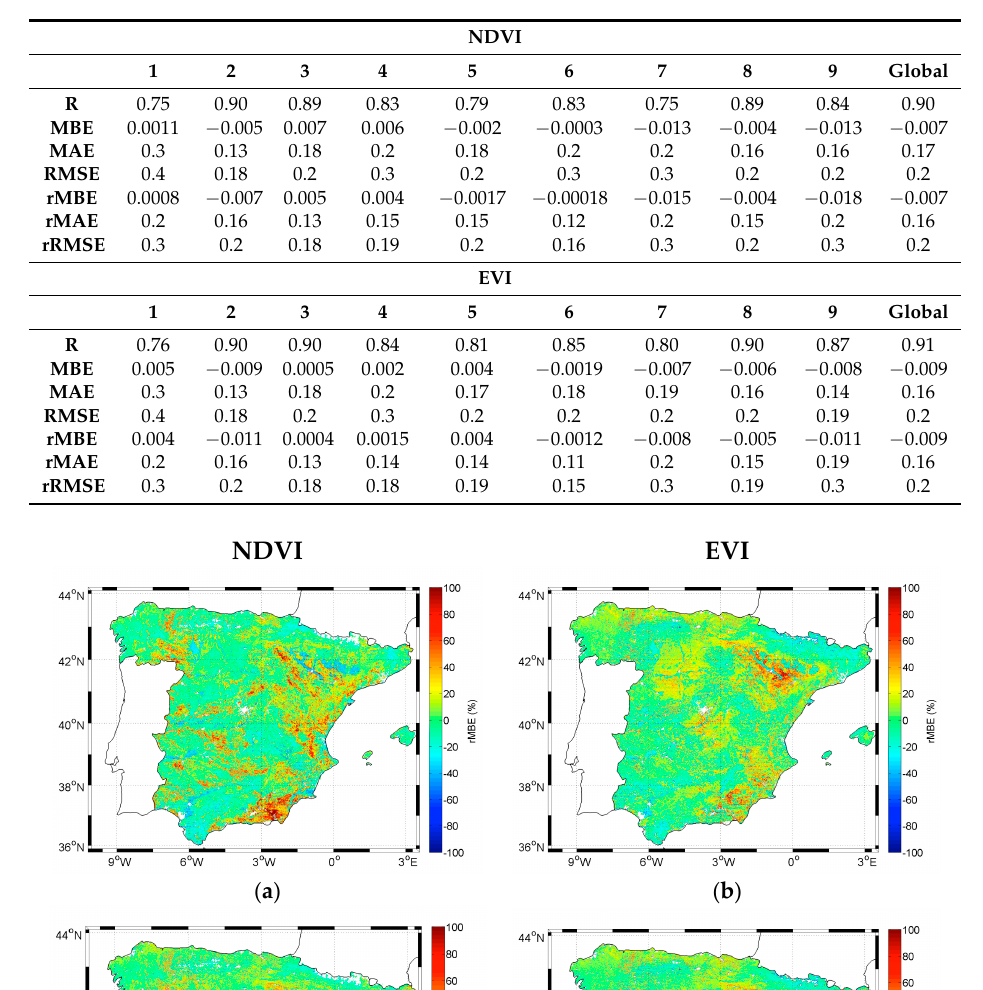
Table 5. Validation statistics for each vegetation type and for the whole data set. Code: (1) irrigated lands; (2) cultivated areas; (3) cropland mosaic; (4) broad-leaved forest; (5) needle-leaved forest; (6) mixed forest; (7) shrubs; (8) herbaceous; and (9) sparse vegetation. MBE, MAE and RMSE are expressed in kg · m − 2 · yr − 1 . Results are shown NDVI and EVI. Remote Sens. 2017 , 9 , 193